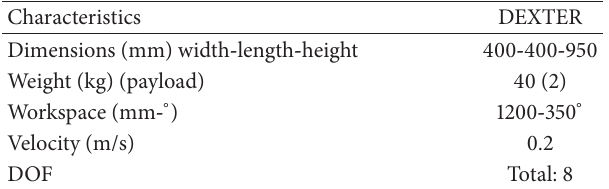
Figure 1: DEXTER bioinspired robotics arm. Table 1: DEXTER characteristics.